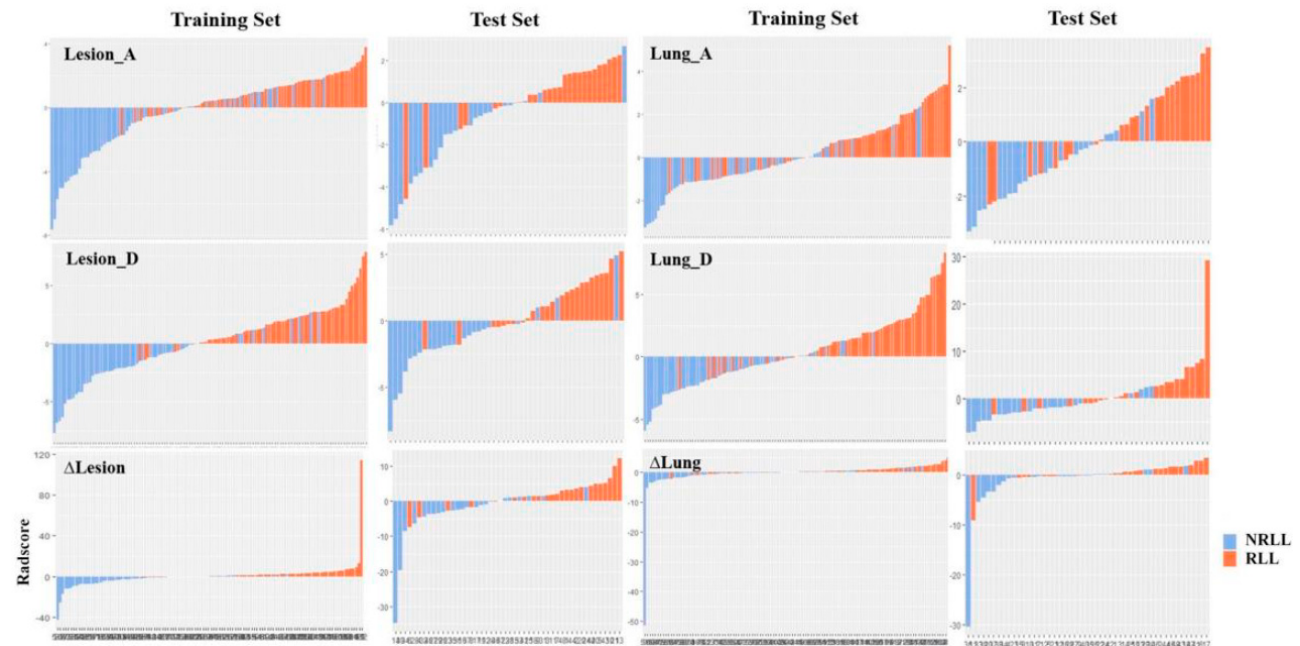
Figure 3. Radiomic scores for each patient in the six models.